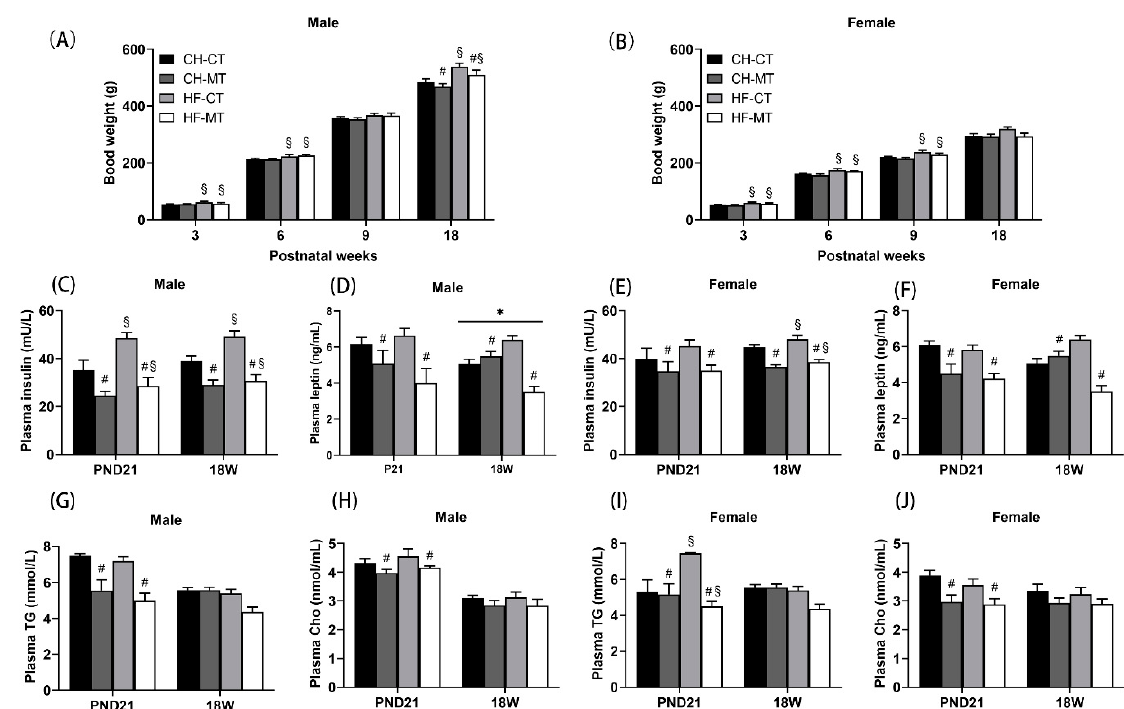
Figure 2. Body weight and plasma profile of offspring. Male ( A ) and female ( B ) offspring were weighed once a week. Plasma insulin ( C ), leptin ( D ), triglyceride (TG) ( G ) and total cholesterol (Cho) ( H ) of male offspring were measured at weaning and 18 weeks. Plasma insulin ( E ), leptin ( F ), TG ( I ) and Cho ( J ) of female offspring were measured at weaning and 18 weeks. Data are expressed as mean ± S.E.M (n = 5–8 per group). Data were analyzed by two-way ANOVA, # main effect of maternal metformin, p < 0.05 versus control, § main effect of maternal HF diet, p < 0.05 versus maternal CHOW diet, * interaction effect of maternal HF diet and metformin, p < 0.05.